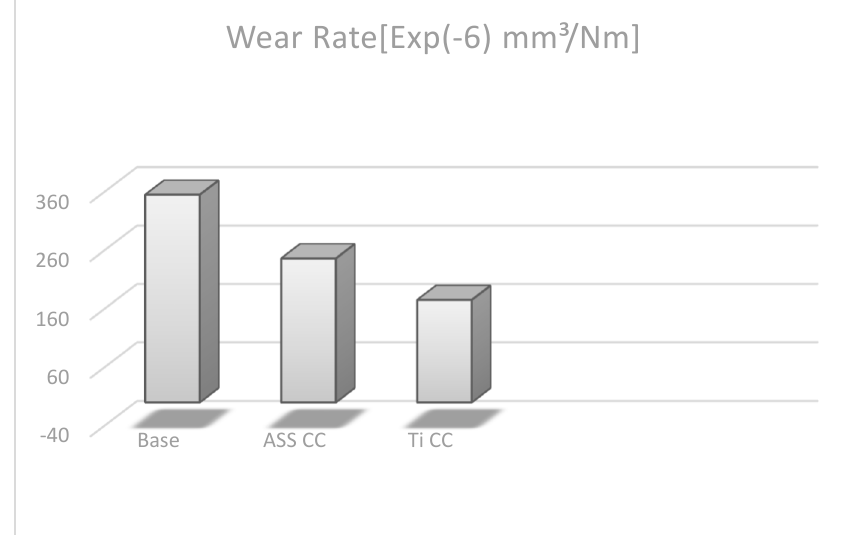
Figure 6. Wear rate diagram of plasma treated and untreated coupons.